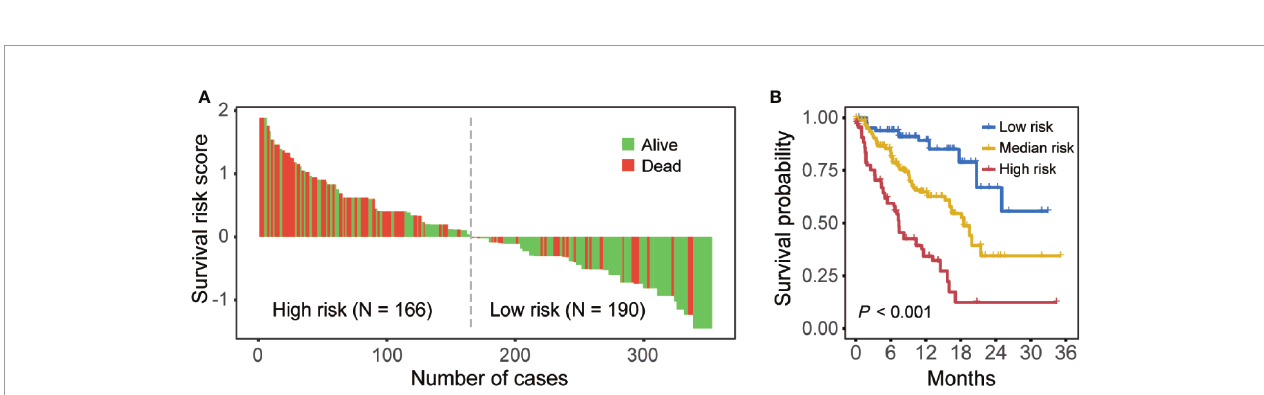
FIGURE 5 | Nomogram-based risk strati fi cations for BM patients. (A) Waterfall plot of risk scores from nomogram prediction. (B) Kaplan – Meier curves for overall survival for patients with low-, medium-, and high-risk scores in the overall